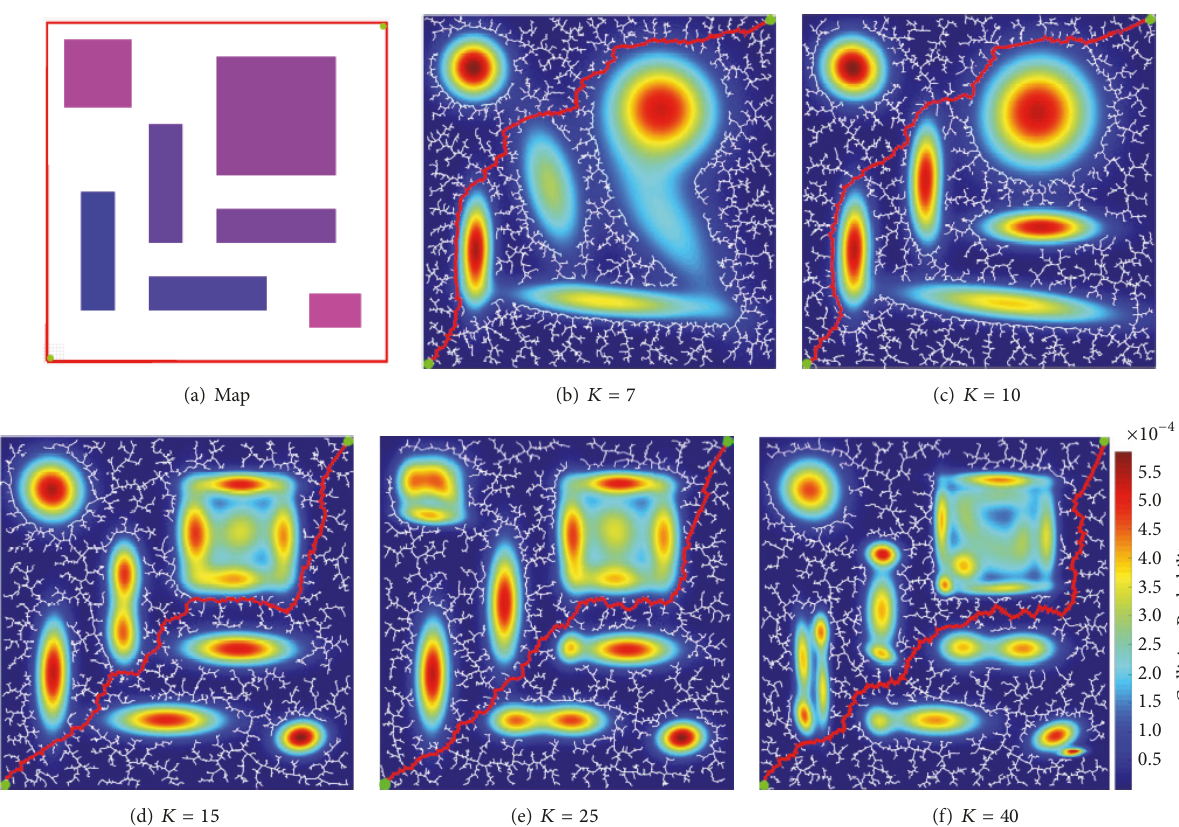
Figure 1: The Gaussian mixture model with different number of components is used to fit the probability distribution of the obstacle regions in the two-dimensional map (a), and the GMM-based collision query method is used to guide the RRT ∗ algorithm to plan the path from the starting point to the end point. The white lines represent the feasible edges that RRT ∗ algorithm explores, the green points are the starting point and the end point of the planning problem, and the red line represents the final